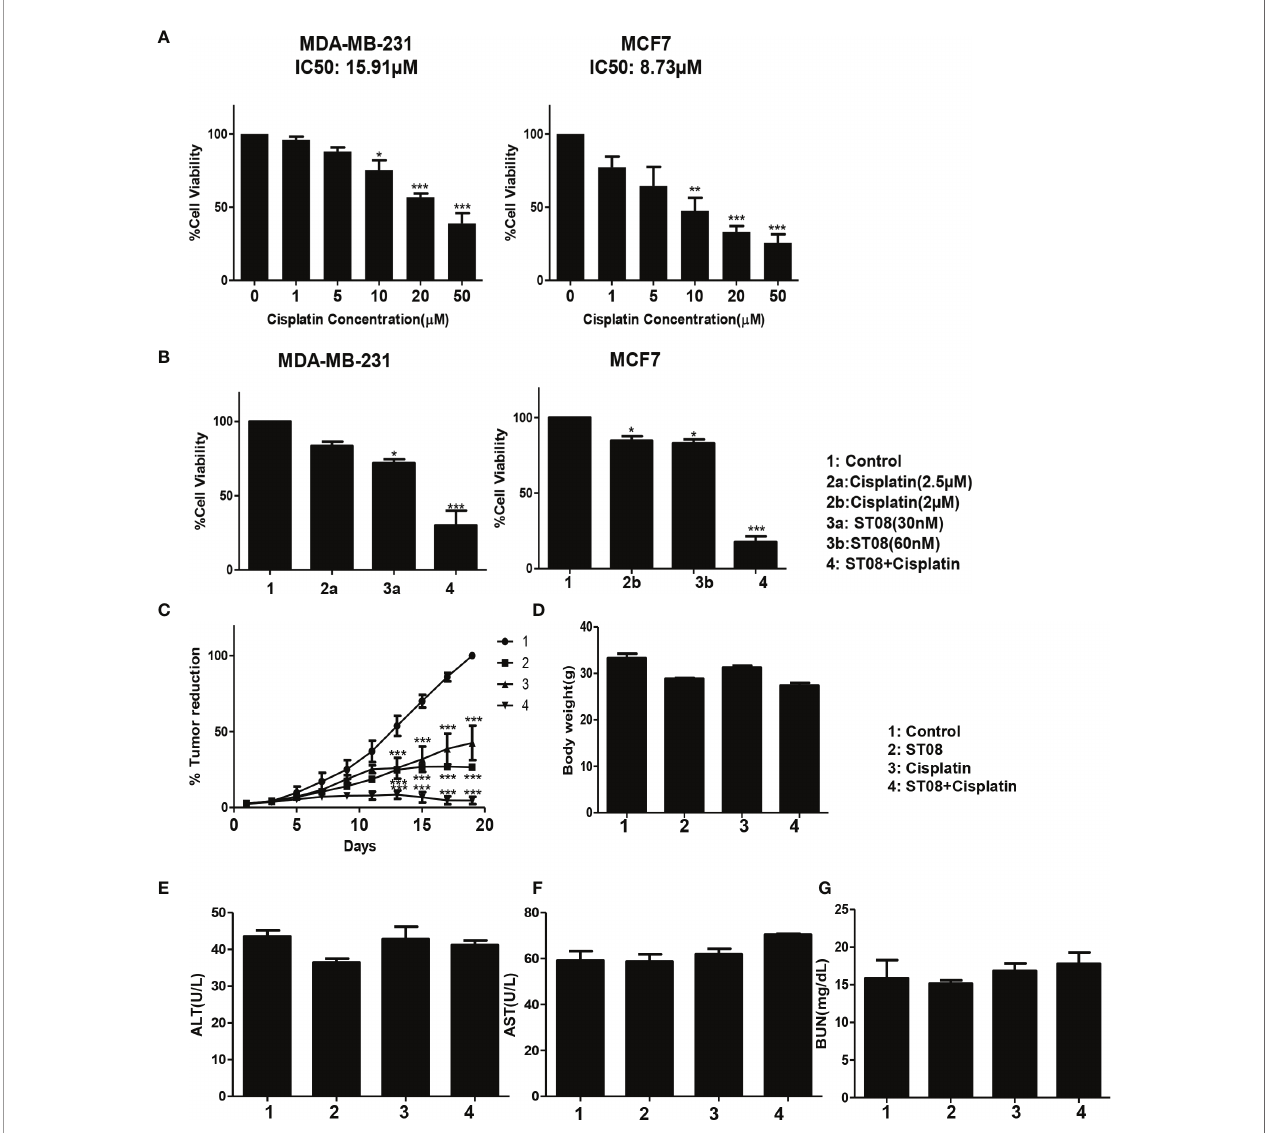
FIGURE 4 | Drug combination study in vitro and in vivo : Bar graph depicting cell viability upon Cisplatin (A) and Combination(ST08+Cisplatin) treatment (B) of 48h on breast cancer cell lines as tested by MTT assay. Experiments were performed a minimum of three times, and the bar graph shows mean ± SEM. Two-way ANOVA test was performed and p-value was calculated between control and treated groups (*p < 0.05, **p < 0.005, ***p < 0.0001). EAC cells (1 x 10 6 cells/animal) were injected to induce solid tumours. After the 7 th day of injection, i.p injection with ST08 (10mg/kg bd.wt), Cisplatin(1mg/kg bd.wt), and ST08+Cisplatin was started every alternate day throughout the experiment period. (C) % Tumour volume reduction after ST08, Cisplatin, ST08+Cisplatin treatment. (D) Body weight of animals at the end of the study. Blood ALT (E) , AST (F) , Urease (G) test results are plotted as bar graphs. Blood was collected at the end of the